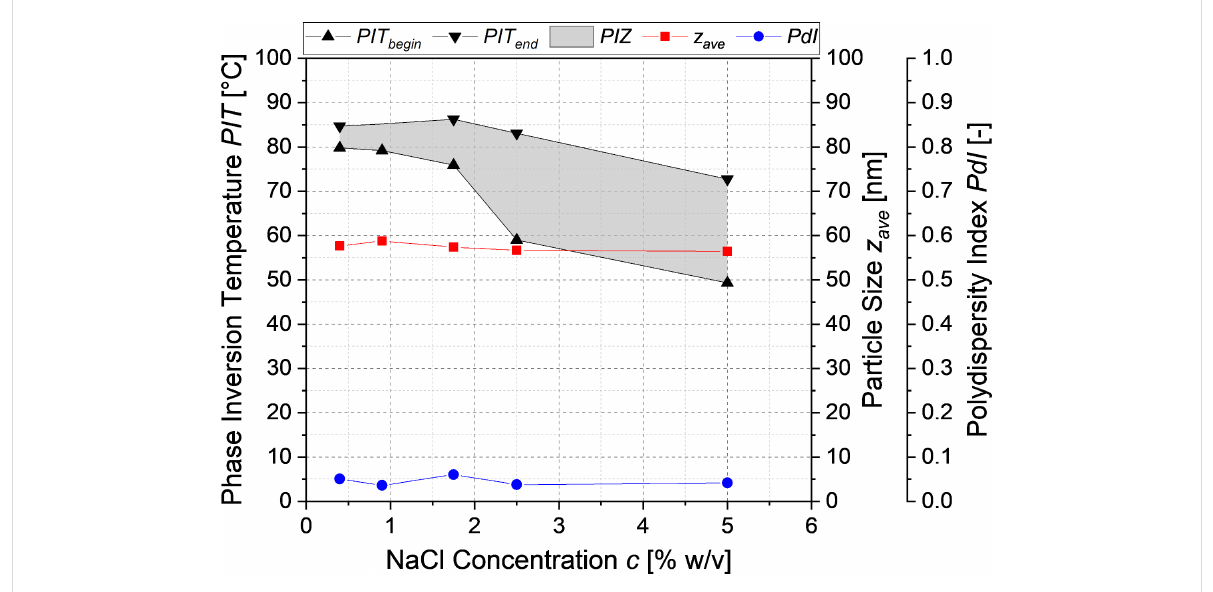
Figure 1: Influence of the salinity of the aqueous phase on the phase inverson zone (PIZ) for the nanoemulsions at a composition of MCT/Kolliphor/ NaCl solution (20:20:60) along with the nanoparticle diameter and the PDI of the resulting nanoemulsion.